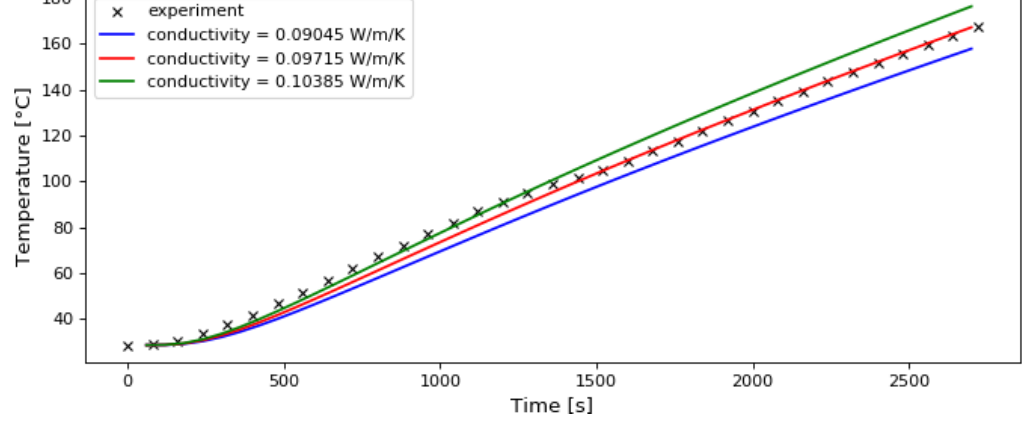
Figure 10. Temperature comparison for three values of H-cement conductivity.